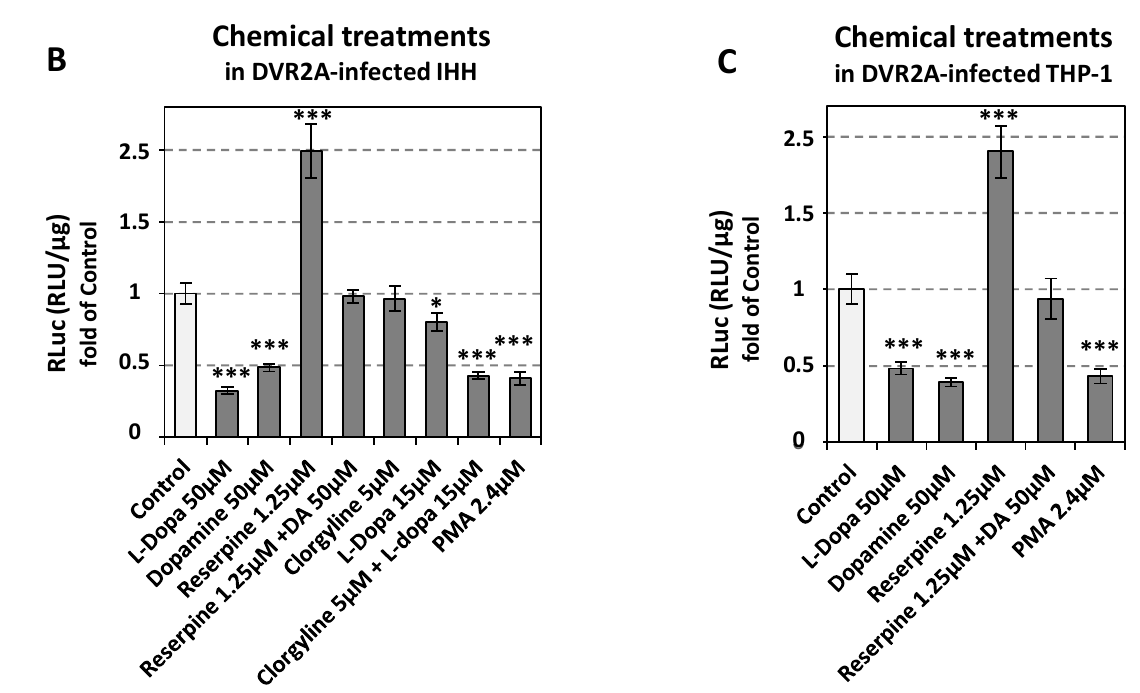
Figure 13. The activity of the catecholamine biosynthesis/metabolism pathway negatively regulates DV replication in immortalized human hepatic (IHH) and blood monocytic (THP-1) cell lines. ( A ) 24 h after electroporation of IHH cells with the shDDC vector, or the shControl vector, cells were infected by DVR2A reporter virus (MOI = 0.1) (( A )-Left) or DV (DV-2 16681 strain, at an MOI = 0.1) (( A )-Right) for 4 h, and after virus inoculum removal were further cultured for the indicated hours post-infection (h.p.i). (( A )-Left) Levels of Renilla luciferase activity (RLuc) , indicative of DV replication, were expressed as RLU/ µ g of total protein amount. (( A )-Right) RT-qPCR analysis was performed to determine DV plus-strand RNA levels. At each time point, values derived from shControl-expressing cells were set to one. *** p < 0.001 vs. shControl at each timepoint. ( B , C ) After a 4 h inoculation of IHH ( B ) or THP-1 ( C ) cells with DVR2A (MOI = 0.1) virus, cells were treated with DDC substrates and products, VMAT-specific inhibitor reserpine, MAO-A inhibitor clorgyline and the catecholamine pathway inducer PMA at the indicated concentrations or were mock-treated (Control), and further cultured for 48 h. Then, the cells were lysed and Renilla luciferase activity was determined. Values are compared to the ones of Control cells (Control). Data shown are means ± standard deviations of values from three independent biological experiments in triplicate. * p < 0.05, *** p < 0.001 vs.